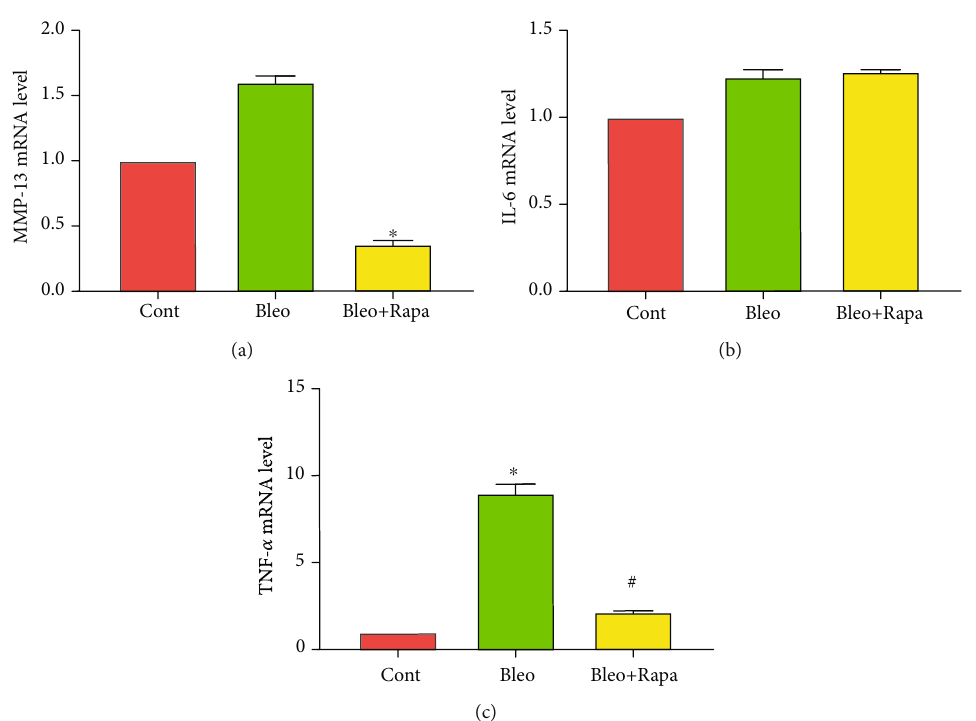
Figure 5: Rapamycin reduces the in fl ammatory/catabolic response in rat PTSCs. (a) qRT-PCR shows that rapamycin decreases the MMP-13 expression that was upregulated by bleomycin. (b) No signi fi cant di ff erence was observed on the IL-6 expression when cells were treated with bleomycin alone, or a combination with rapamycin. (c) Rapamycin decreases the bleomycin-induced TNF- α expression. Results are expressed as mean ± SD , n = 3 . ∗ p < 0 : 05 compared to control, # p < 0 : 05 compared to the bleomycin treatment group. Cont: control; Bleo: bleomycin; Rapa: